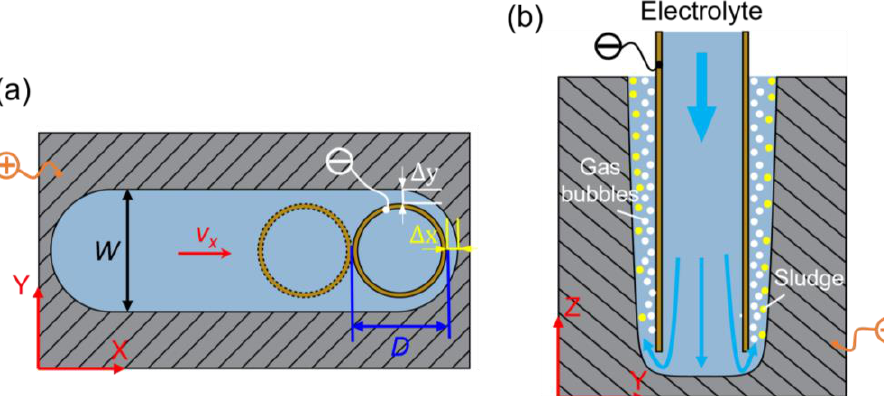
Figure 2. Diagram of the electrochemical milling process: ( a ) Sketch of the X-Y plane and ( b ) sketch of Y-Z plane.